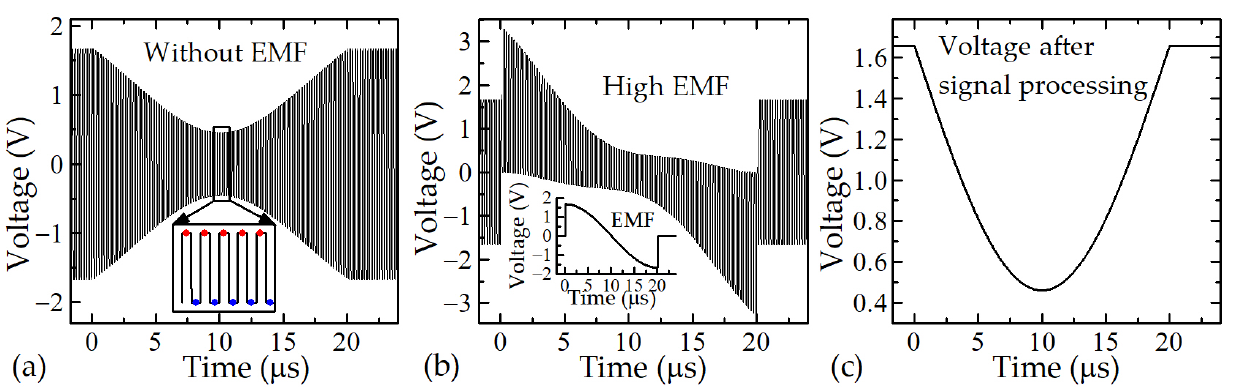
Figure 8. Voltage across the CMR sensor powered by pulsed voltage during application of pulsed magnetic field: ( a ) without the EMF; ( b ) with the EMF; ( c ) after signal processing. Inset: in ( a )—points indicate time instants at which the ADC reads positive and negative voltage values; in ( b )—EMF induced in the sensor and its